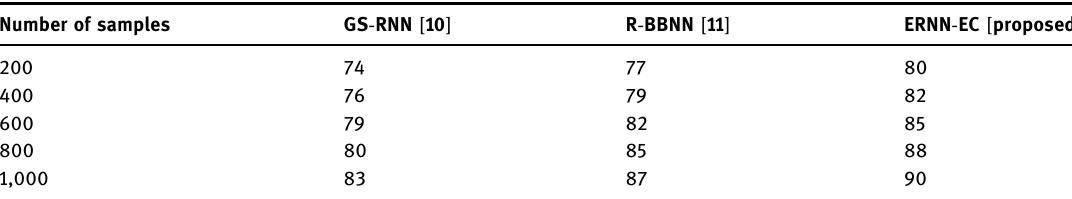
Table 5: Analysis of recall